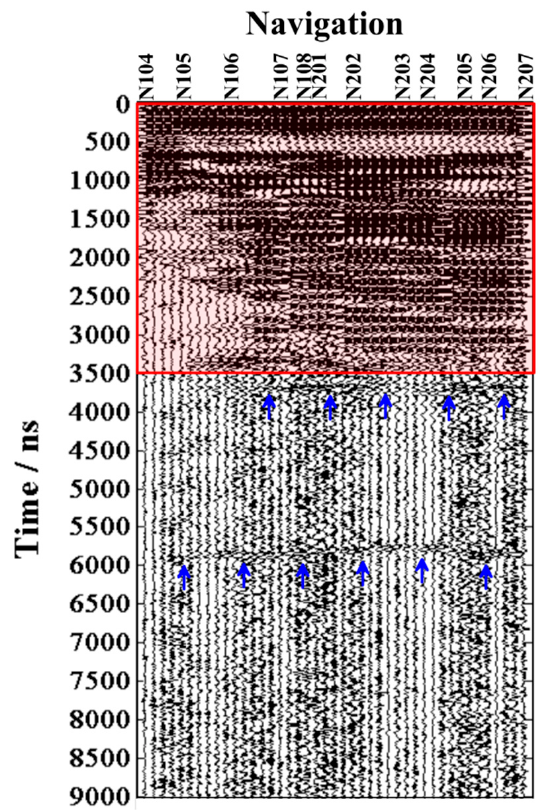
Figure 4. LPR CH-1 data with interpretation.